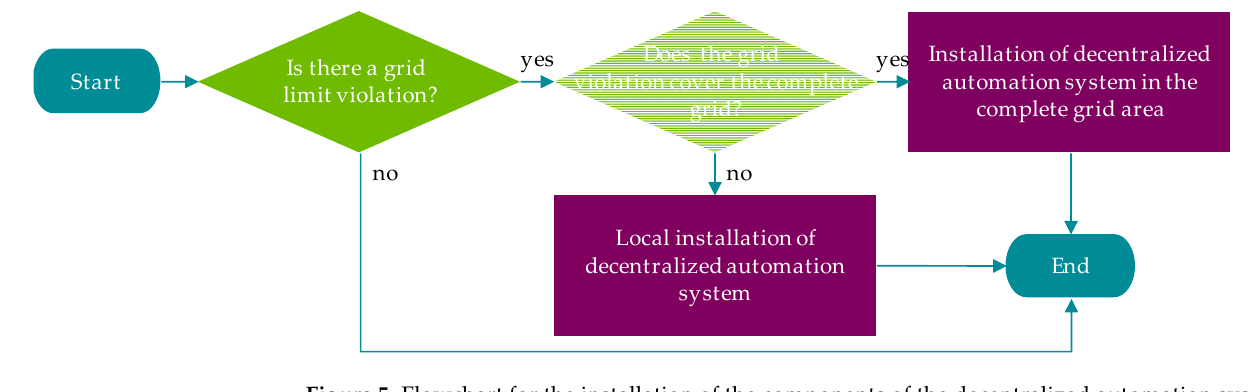
13 Table 3. Overview of the regulated load for each of the three load management variants (“ ✓ ”: reg- ulated, “-”: not regulated). Regulated Load